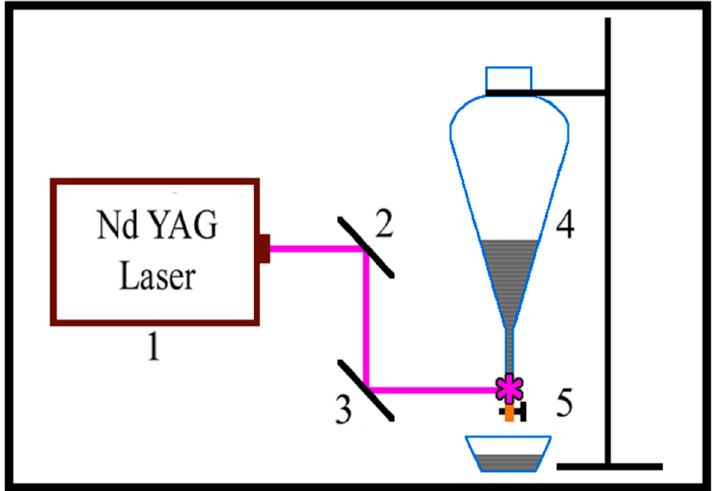
Figure 1. Schematic diagram of the experimental setup: 1—Nd: YAG laser; 2 and 3—Mirrors; 4—Dropping funnel; 5—Dosing quartz tube.